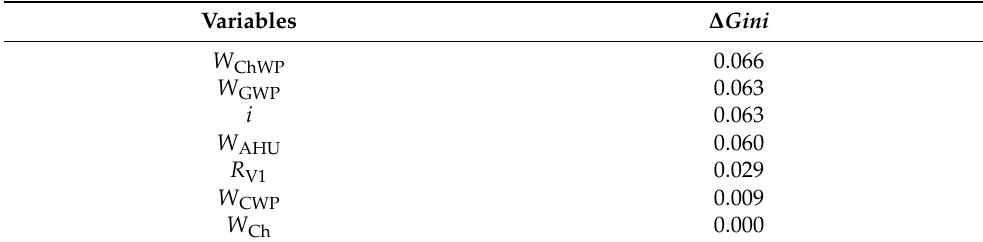
Table A6. ∆ Gini values for variables at node 5.